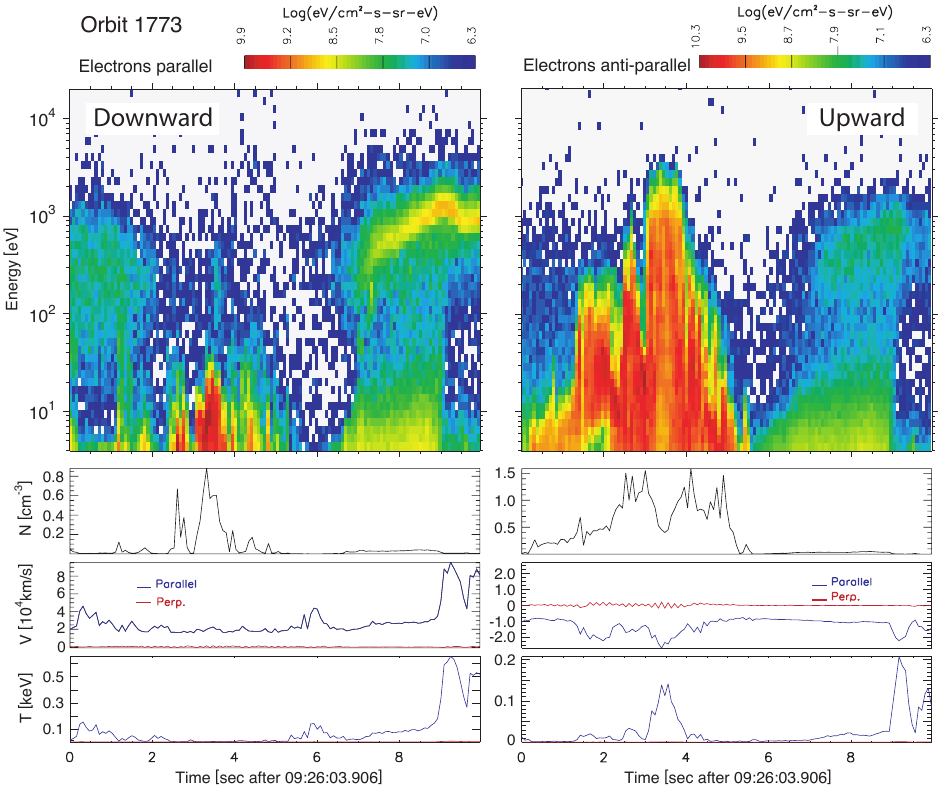
Fig. 2. A high resolution view of the second downward current event in Fig. 1 for downward (left) and upward (right) electron fluxes. Downward fluxes [i.e. the v k > 0 tail of f e (v k ) ] are low energy ∼ 10eV with density . 1cm − 3 . [Downward bulk velocities between 2s < t < 4s are formally obtained from the downward part of f e (v k ) , i.e. the downward tail of the distribution function, and are not real.] Upward fluxes reach densities of & 1.5cm − 3 . Plasma frequencies in this region range around 10kHz . ω e / 2 π . 14kHz. Upward bulk velocities range between 10 4 kms − 1 . V < 2 . 5 × 10 4 kms − 1 while temperatures maximise at T ∼ 150eV. Thus the thermal velocities are v e < 5 × 10 3 kms − 1 . Under these conditions the Buneman instability grows resulting in formation of chains of electron